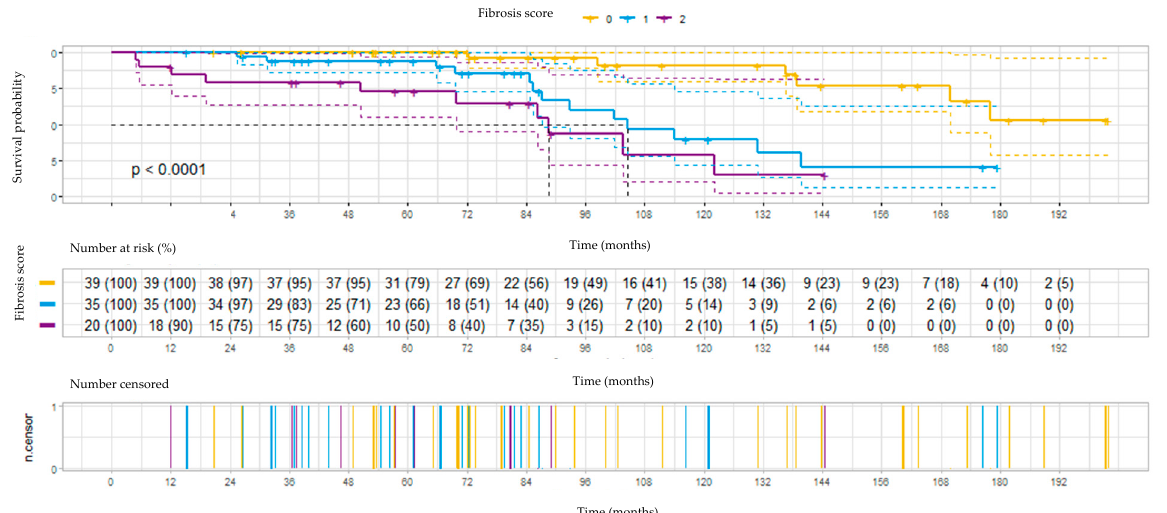
Figure 1. Kaplan–Meier survival curves in three different treatment outcome group: 0—progression, Figure 1. Kaplan – Meier survival curves in three different treatment outcome group. 0 – 1—stable disease, 2—improvement.